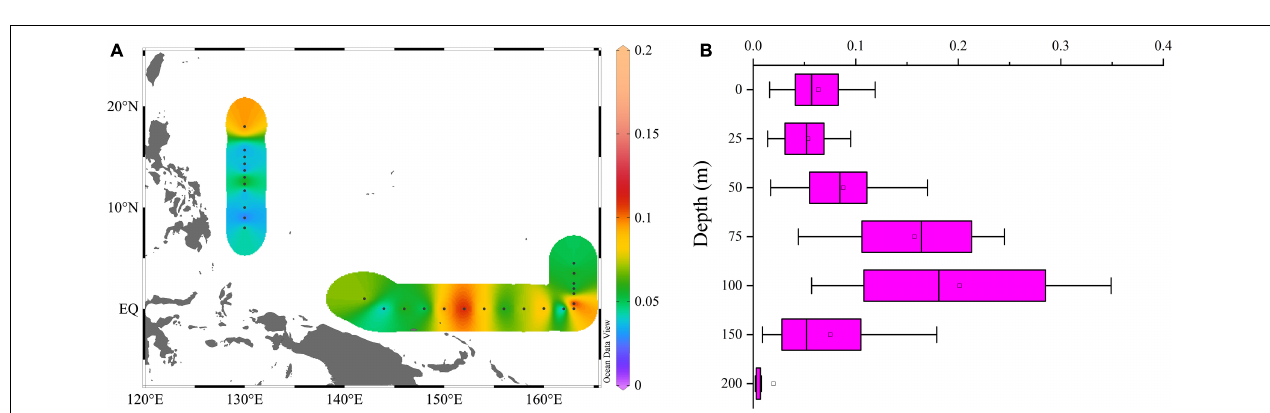
FIGURE 8 | Spatial distributions of depth-weighted average carbon biomass (mg C/L) of Synechococcus ; Prochlorococcus ; Picoeucaryote.